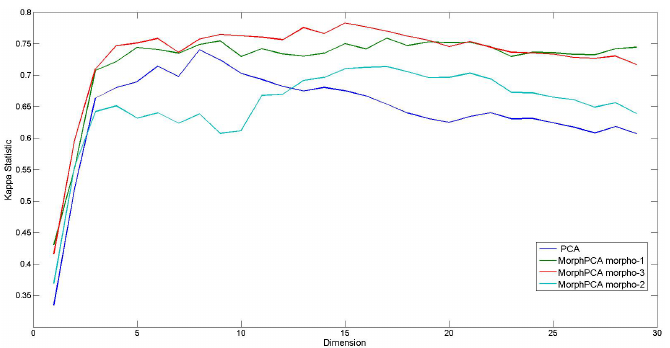
Figure 18. Results of kappa statistic for the least square SVM with a RBF kernel and different number of dimensions on Indian Pines hyperspectral image, the size of training set is equal to 5%.